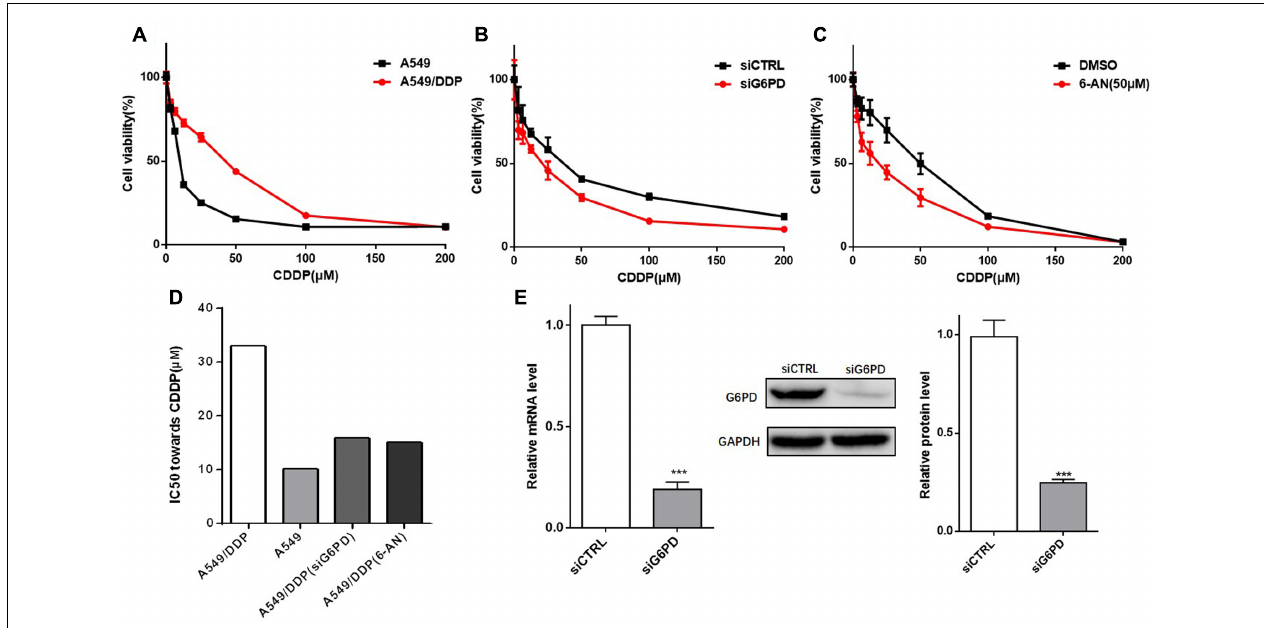
FIGURE 4 | Inhibition of G6PD significantly decreased the cell viability of A549/DDP cells to cisplatin. (A) The resistance of A549/DDP cells was determined by a MTT assay. (B) A549/DDP cells transfected with siRNA were cultured for 48 h with various concentrations of cisplatin (3.125– 200 µ M), and the cell viability was determined. (C) A549/DDP cells were treated with cisplatin alone or in combination with 6-AN for 48 h, and cell viability was determined. (D) The IC 50 toward CDDP in (A–C) were calculated and is presented as a column chart. (E) The reduction of G6PD expression by siRNA was confirmed by qRT-PCR and western blot analysis. Data are presented as the means ± SD ( n = 3), and significant differences are indicated as ∗ P < 0.05, ∗∗ P < 0.01, and ∗∗∗ P <